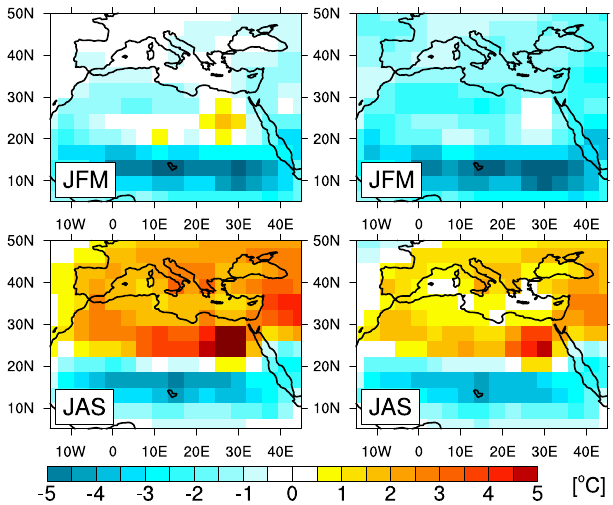
Fig. 7. Anomalies of 2-meter air temperature for winter (JFM) and summer (JAS) from global simulations, 9K1 vs. CTRL (left) and 9K2 vs. CTRL